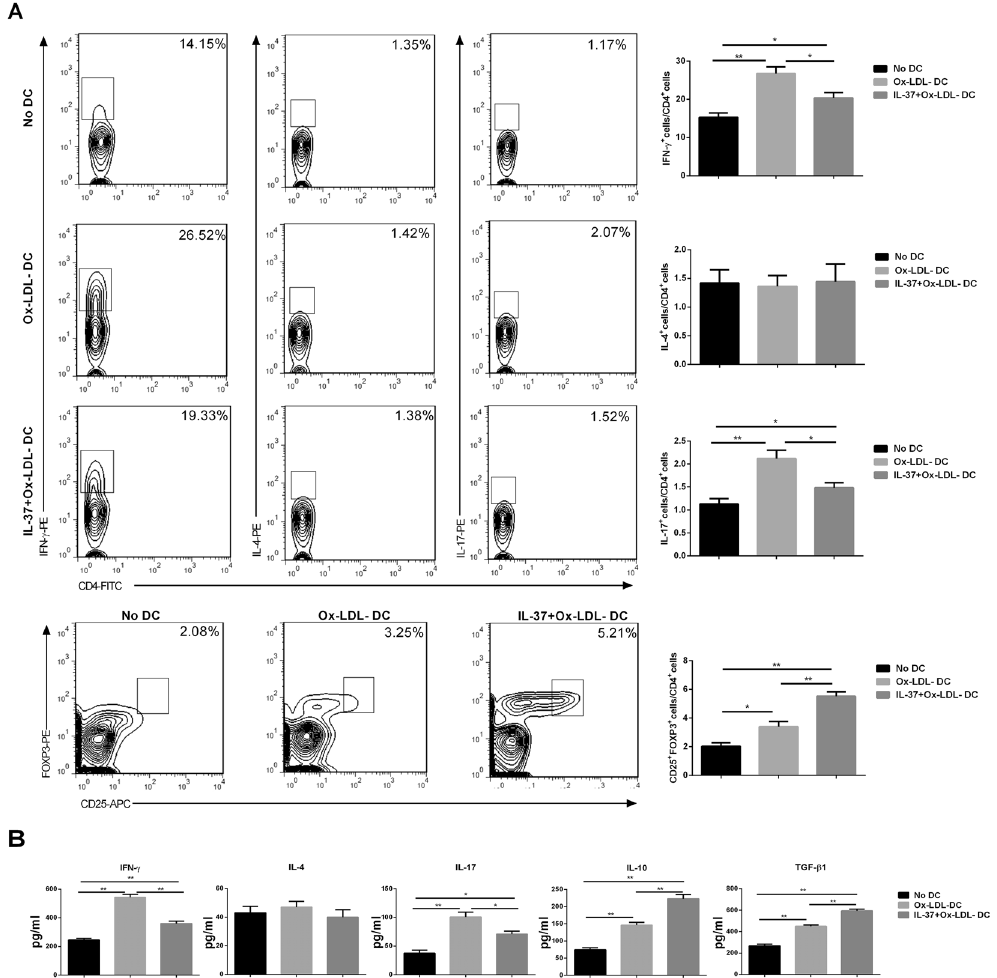
Figure 5. Effect of IL-37 on the Th1/Th2/Th17/Treg paradigm in vitro . ( A ) Flow cytometry results of (CD4 + IFN- γ+ ), Th2 (CD4 + IL-4 + ), Th17 (CD4 + IL-17 + ), and Tregs (CD4 + CD25 + FOXP3 + ) are shown. Results of statistical analysis of Th1 cells, Th2 cells, Th17 cells, and Tregs. ( B ) Results of statistical analysis of the cytokine levels in the cultured supernatant. The data represent 3 experiments in each group. Values are presented as the means ± SEM. * p < 0.05, and ** p <